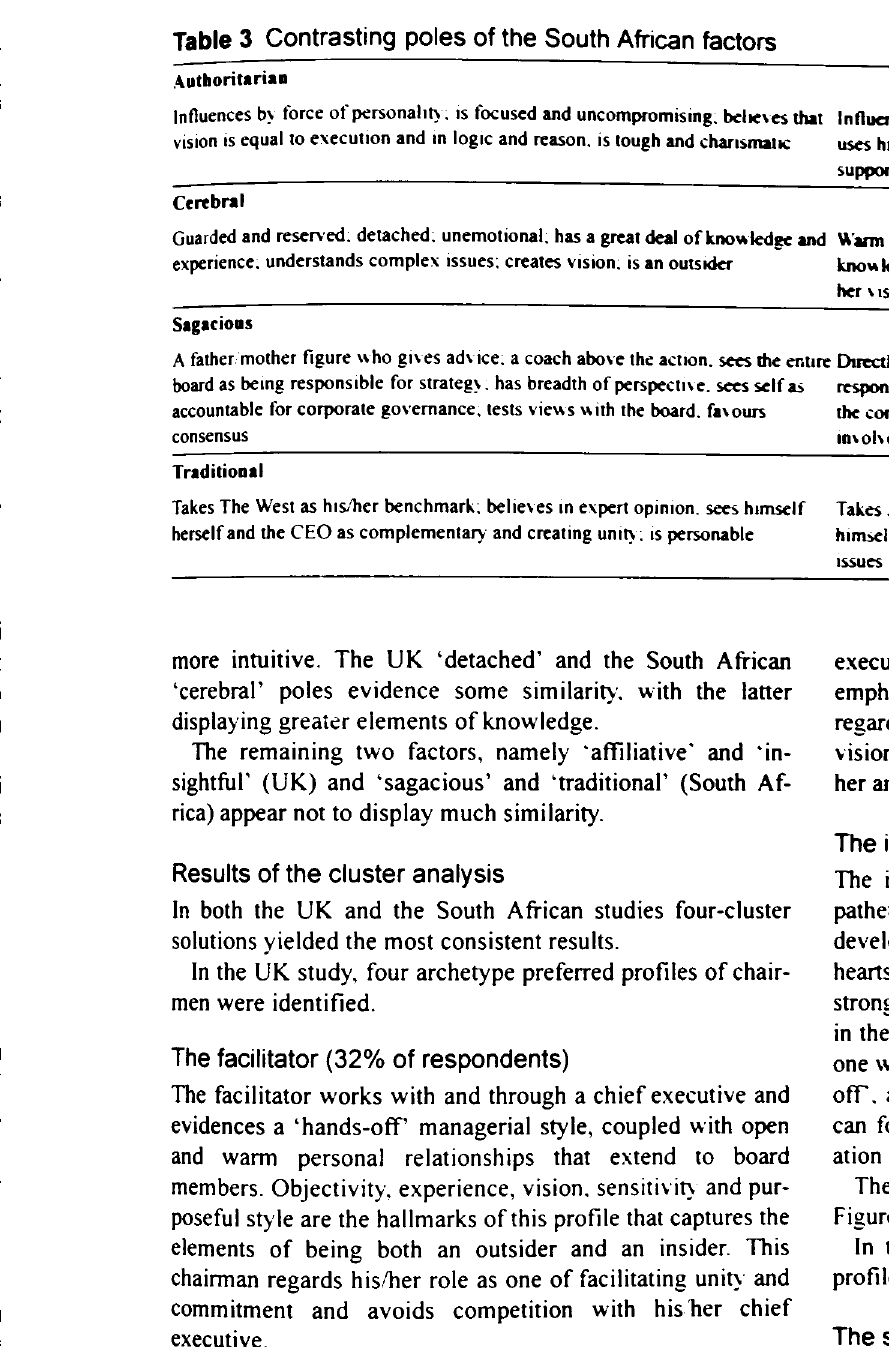
Table 3 Contrasting poles of the South African factors